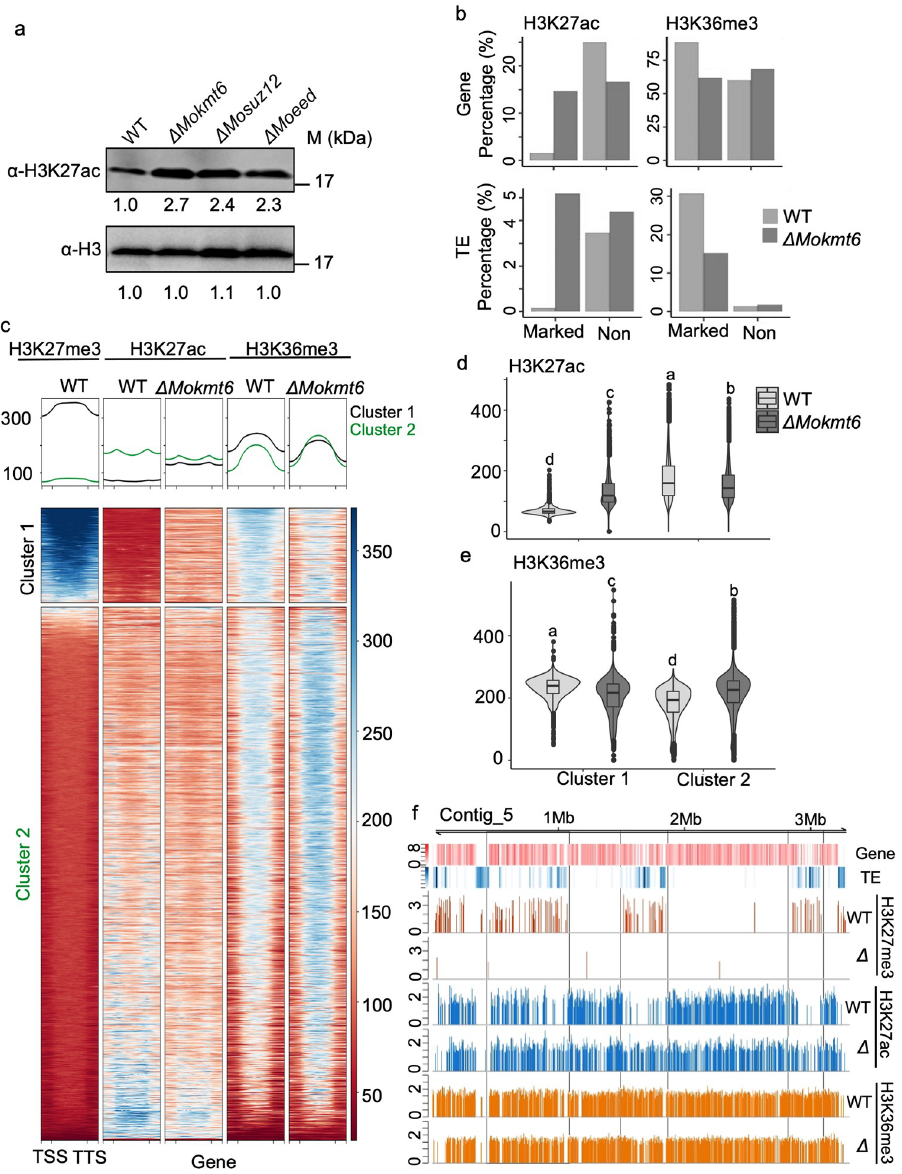
Fig 3. Loss of H3K27me3 leads to redistribution of H3K27ac and H3K36me3. (A) Western blotting analysis showed the global increased levels of H3K27ac in Δ Mokmt6 , Δ Mosuz12 and Δ Moeed with absence of H3K27me3 compared with Guy11 wild type (WT). (B) Bar chart illustrating dynamics of H3K27ac (left) and H3K36me3 (right) marked genes and transposable elements (TEs) compared between wild type (blue) and Δ Mokmt6 mutant (red). (C) Heat maps visualizing profiles of ChIP signals for H3K27me3, H3K27ac and H3K36me3 across 12,101 genes in Guy11 wild type and mutant Δ Mokmt6 . Two clusters of genes are generated by unsupervised k-means analysis and ranked according to their H3K27me3 enrichment from wild type growing in liquid complete medium. (D) and (E) Violin plots illustrating redistribution of ChIP signals for H3K27ac and H3K36me3 in two clusters from the heatmap (C). Letters at the top indicating the significance. (F) ChIP signal showing the loss of H3K27me3 in mutant Δ Mokmt6 ( Δ ) resulted in the redistribution of H3K27ac and H3K36me3 at specific loci. ChIP signals are compared between Guy11 wild type and mutant Δ Mokmt6 growing in liquid complete